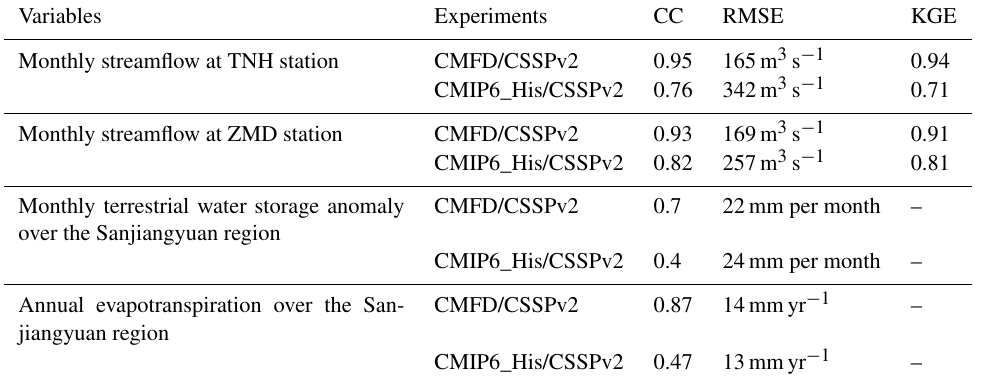
Table 3. Performance of CSSPv2 model simulations driven by the observed meteorological forcing (CMFD/CSSPv2) and the bias-corrected CMIP6 historical simulations (CMIP6_His/CSSPv2). The metrics include the correlation coefficient (CC), root mean square error (RMSE) and Kling–Gupta efficiency (KGE). The KGE is only used to evaluate